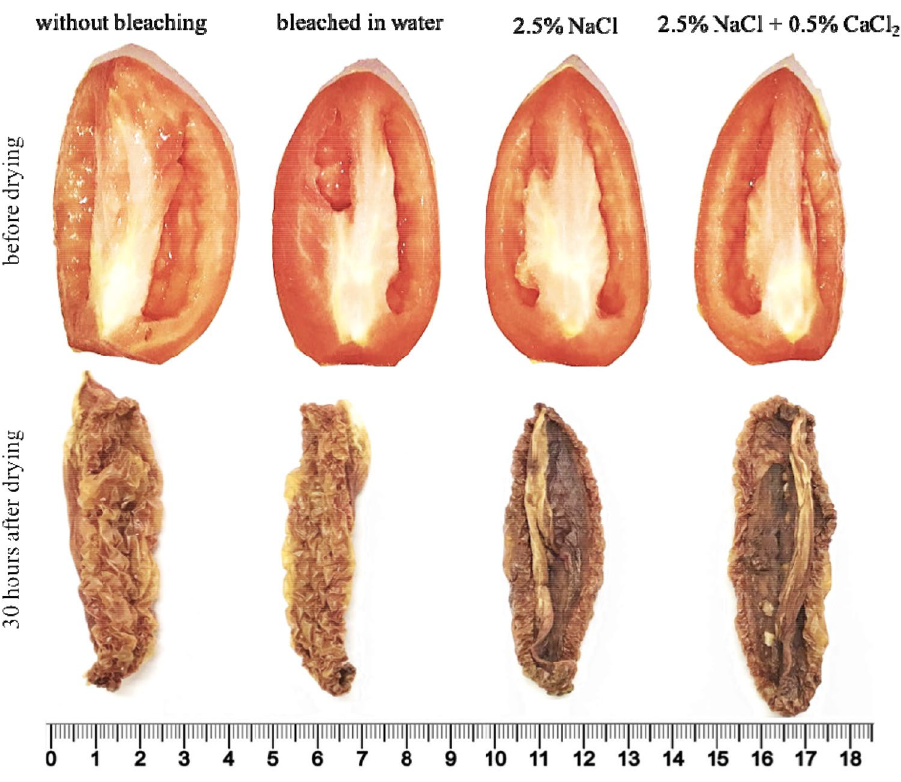
Figure 2. General view of ’Carmen’ tomatoes pre-treated before drying and 70 h after drying. Scale in centimeters. Source: authors.